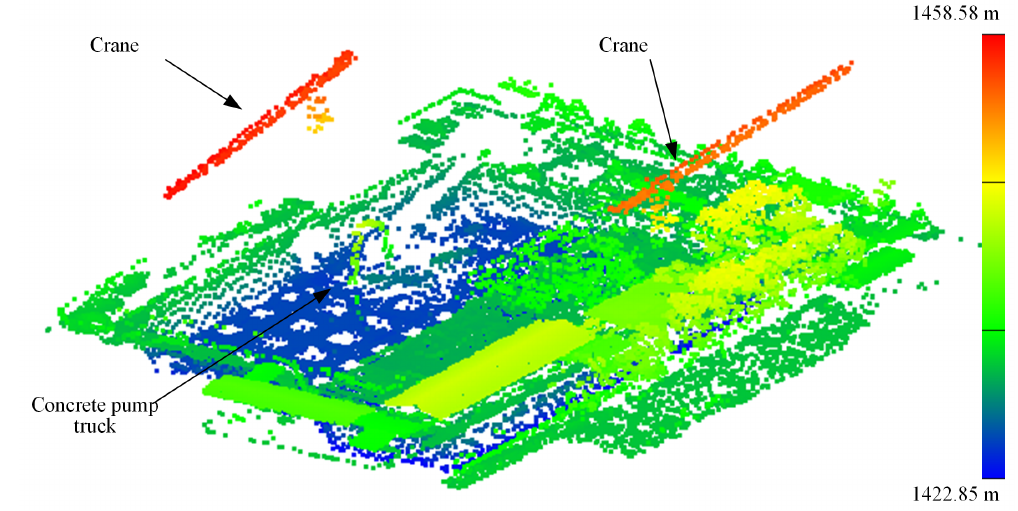
Figure 10. ALS point cloud of the aforementioned construction site. Points are rendered with intensity